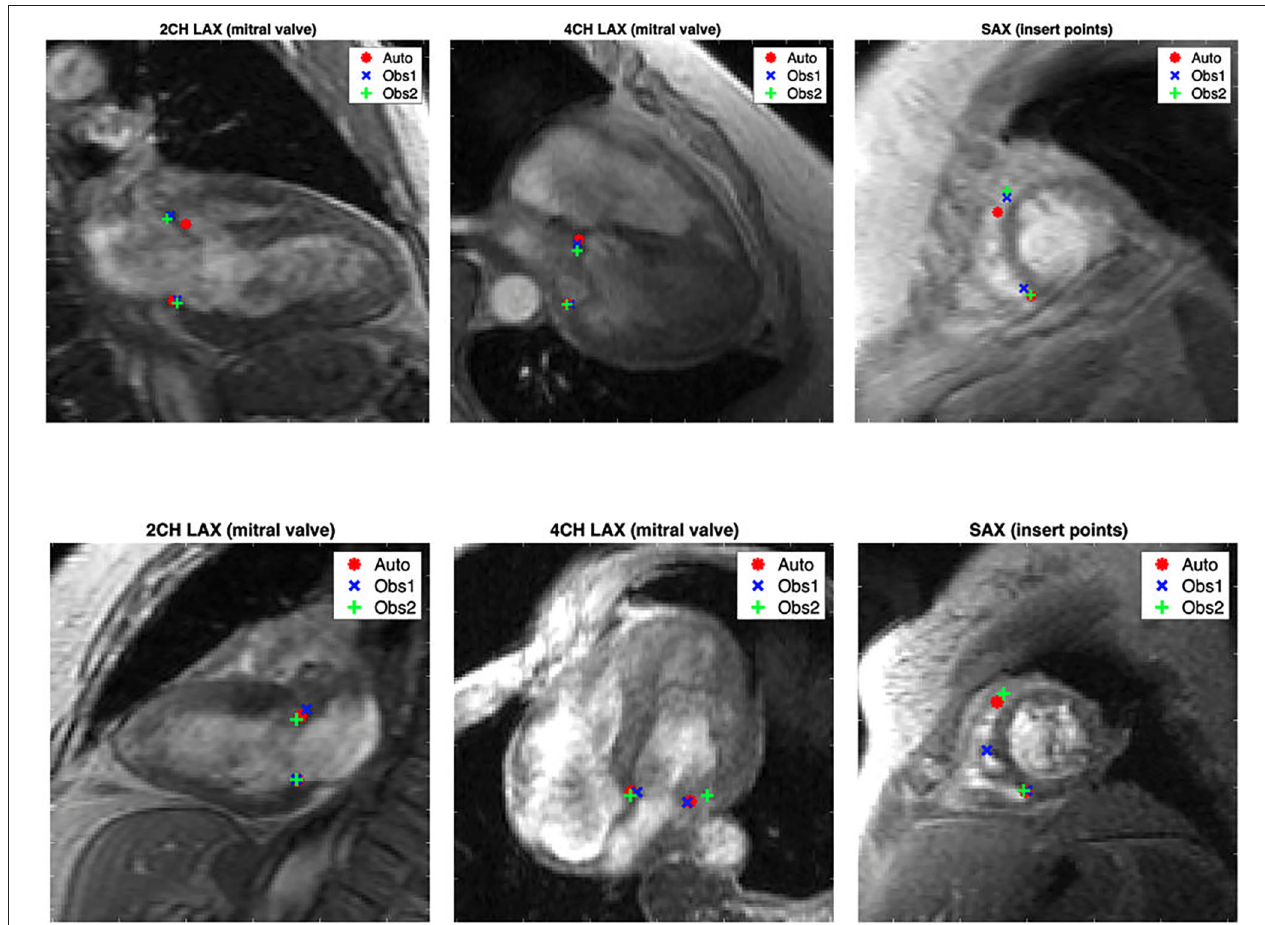
FIGURE 4 | Examples of automated landmark detection (red markers) compared with manually defined placements by two observers (blue and green markers). The top row shows cases with the maximum distance of automated detection to one of the observers while interobserver distances are small. The bottom row shows cases with the largest interobserver distances.